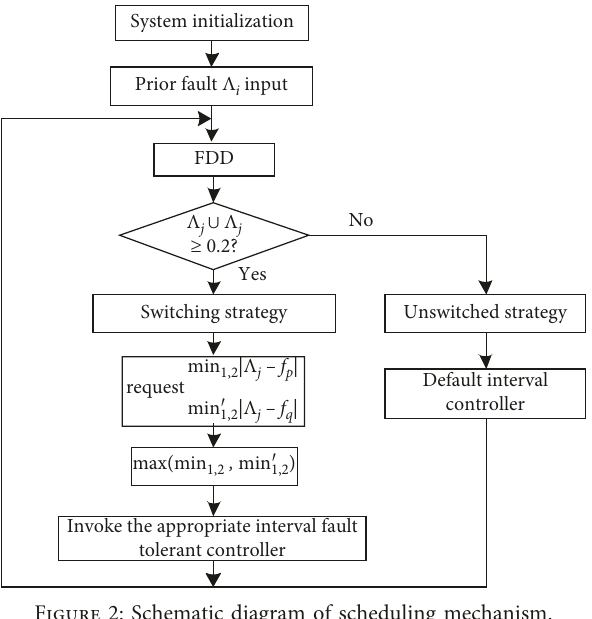
Figure 2: Schematic diagram of scheduling mechanism.